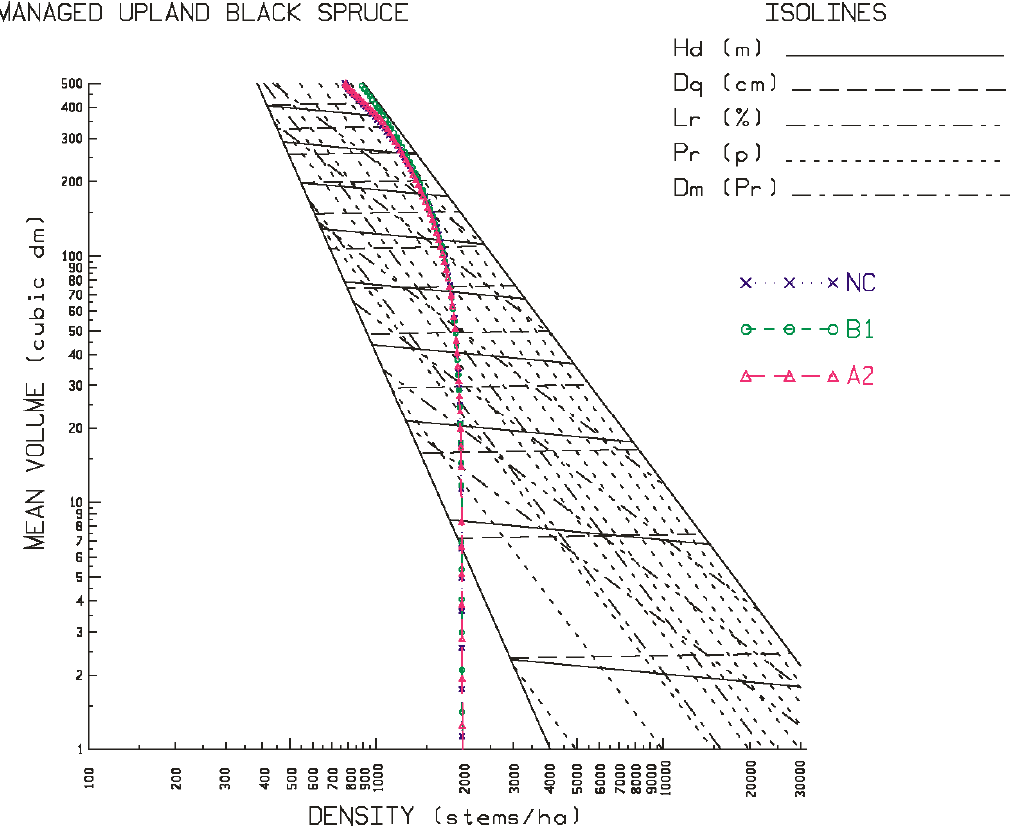
Figure 2. Temporal size ‐ density trajectories by scenario for black spruce plantations within the context of the SSDMM graphic for good ‐ to ‐ excellent quality sites ( S I = 12.6) within north ‐ eastern Ontario. Note, all graphical denotations and definitions follow that given in the caption of Figure 1. Source: Modified SSDMM for black spruce.